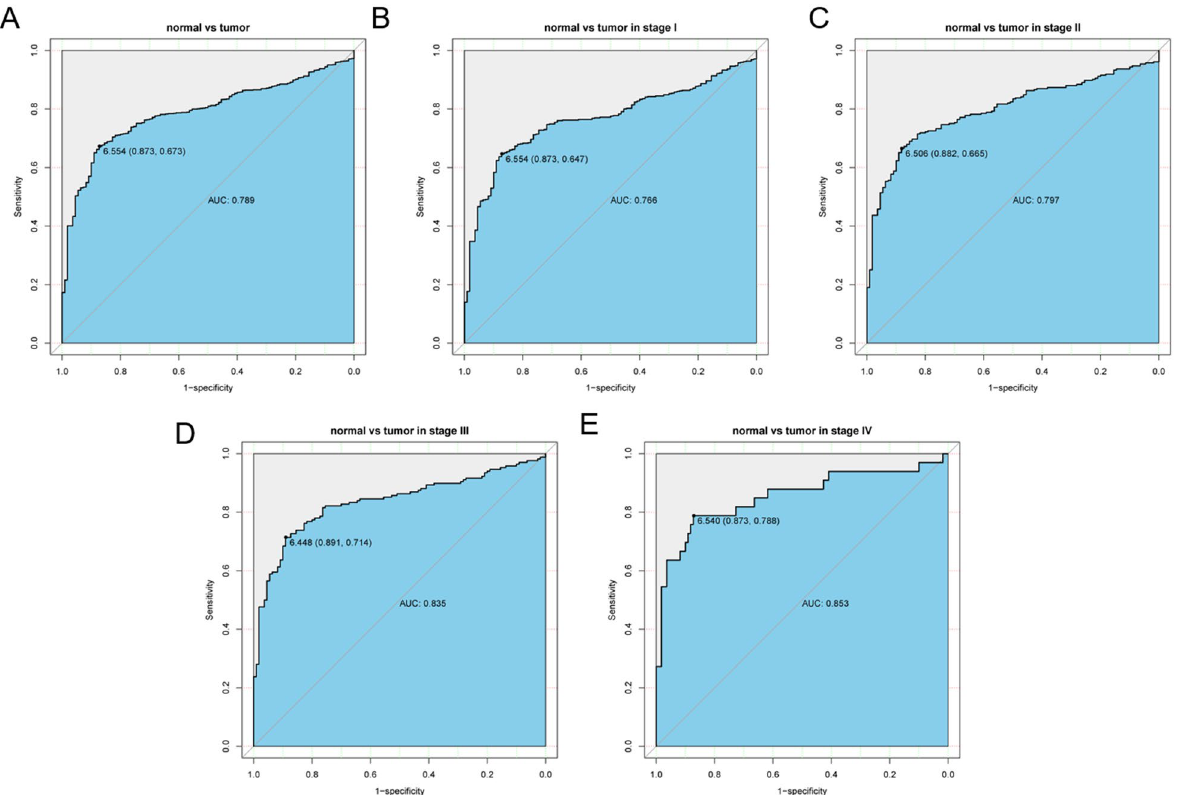
Figure 3. ROC (Receiver operating characteristic) curves of KLRK1 expression in patients with lung cancer. ( A ) Normal vs. overall, ( B ) stage I, ( C ) stage II, ( D ) stage III and ( E ) stage IV